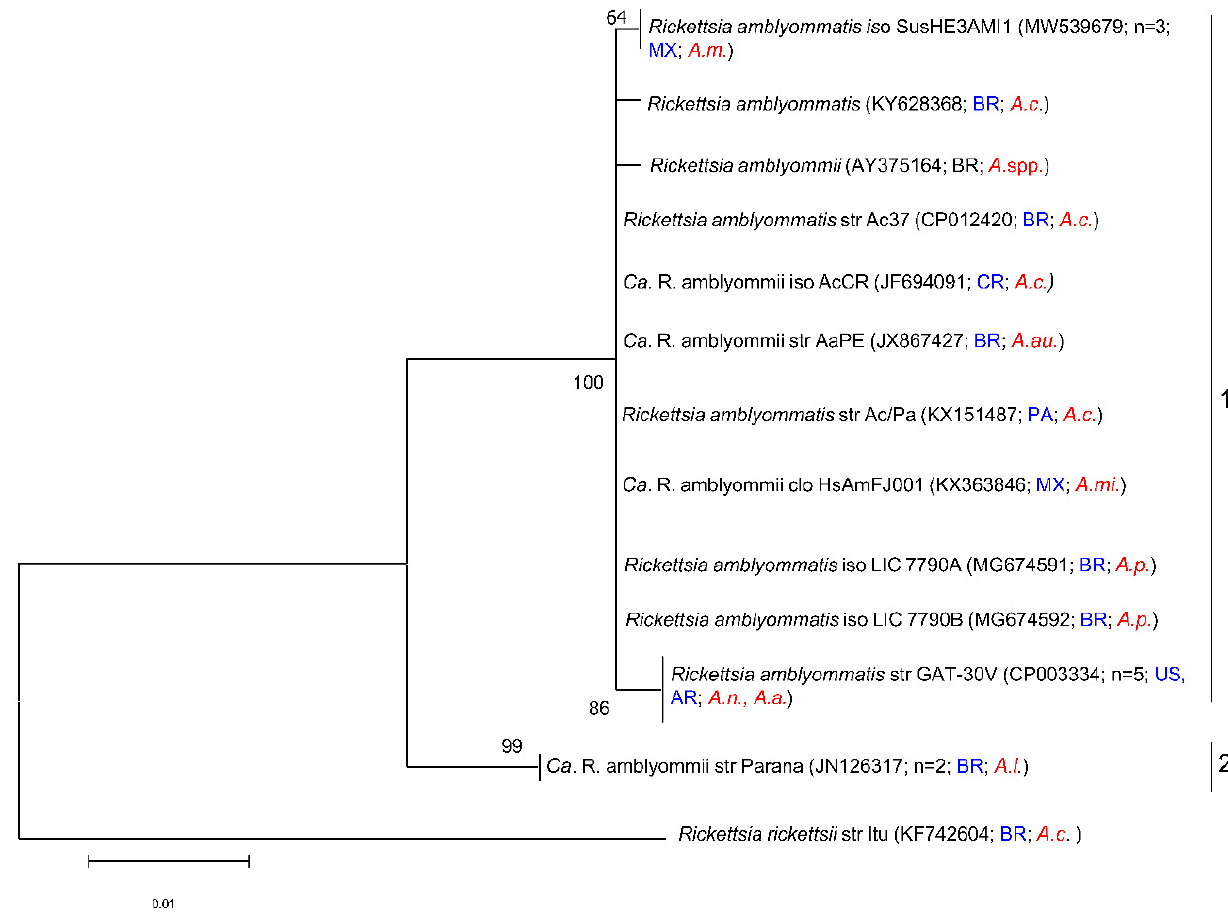
Figure 4. Phylogenetic tree of published sequences and reports of Rickettsia amblyommatis in ticks. The analyses were based on 20 partial sequences of the ompB gene region of Rickettsia amblyommatis within 618 bp obtained from NCBI BLAST. The phylogenetic analysis was completed using a maximum likelihood method on the Kimura 2-parameter model (ML; bootstrap replicates: 1000). This tree is collapsed with nodes organized by sequence differences of 0.001 (n shows the total number of sequences included in that group). Instances in which papers reported the species as “ Rickettsia spp.” but indicated in the publication that the species was R. amblyommatis were included in this analysis. The GenBank accession numbers are given in parentheses. Scale bars indicate the number of substitutions per nucleotide position. This phylogenetic tree was created using MEGA11. Tick species included in this tree are as follows: A. americanum (A.a.) , A auricularium (A.au.) , A. cajennense